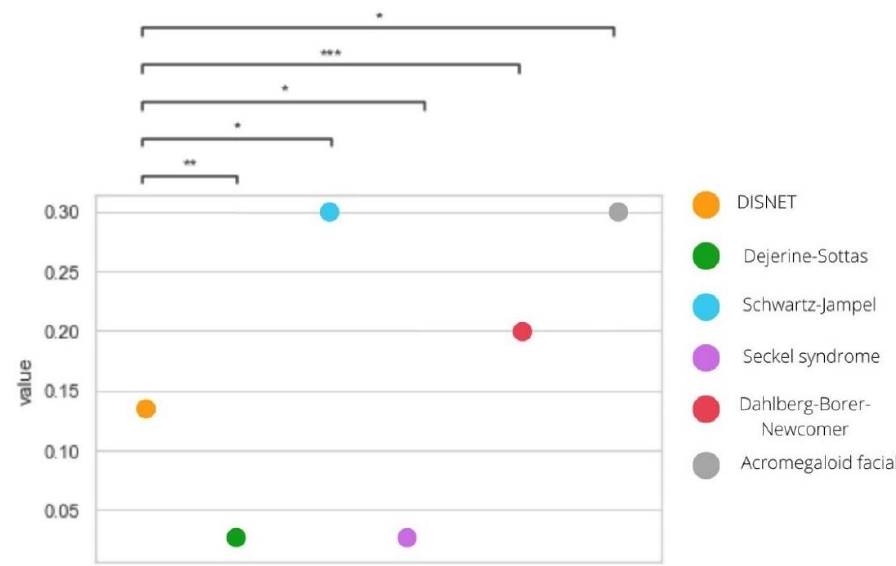
Figure 6. Representation of the statistical differences between the GDA score value of the rare diseases considered and the DISNET value. p -value annotation legend: ns: 5.00 × 10 2 < p < = 1, *: 1.00 × 10 − 2 < p < = 5.00 × 10 − 2 , **: 1.00 × 10 − 3 < p < = 1.00 × 10 − 2 and ***: 1.00 × 10 − 4 < p < = 1.00 × 10 − 3 .